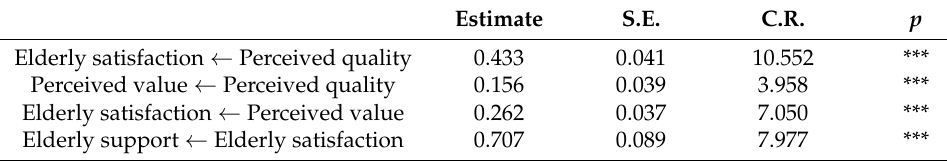
Table 10. Significance test of the latent